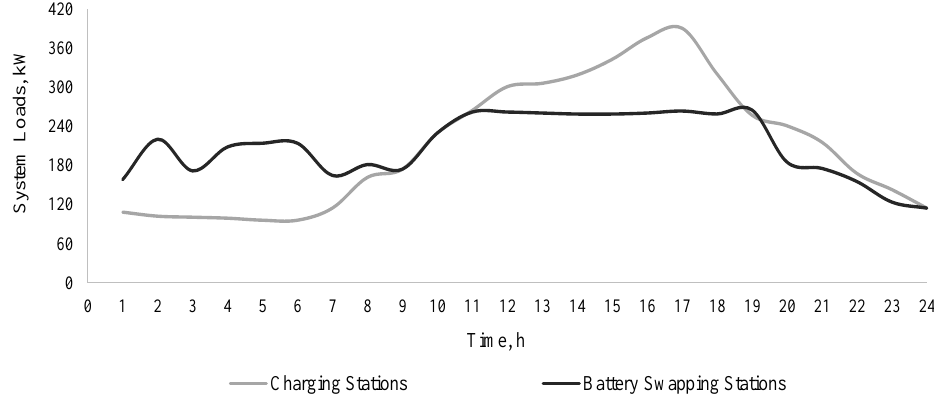
Figure 7. The distribution system’s load at location 31 considering charging and battery-swapping sta-